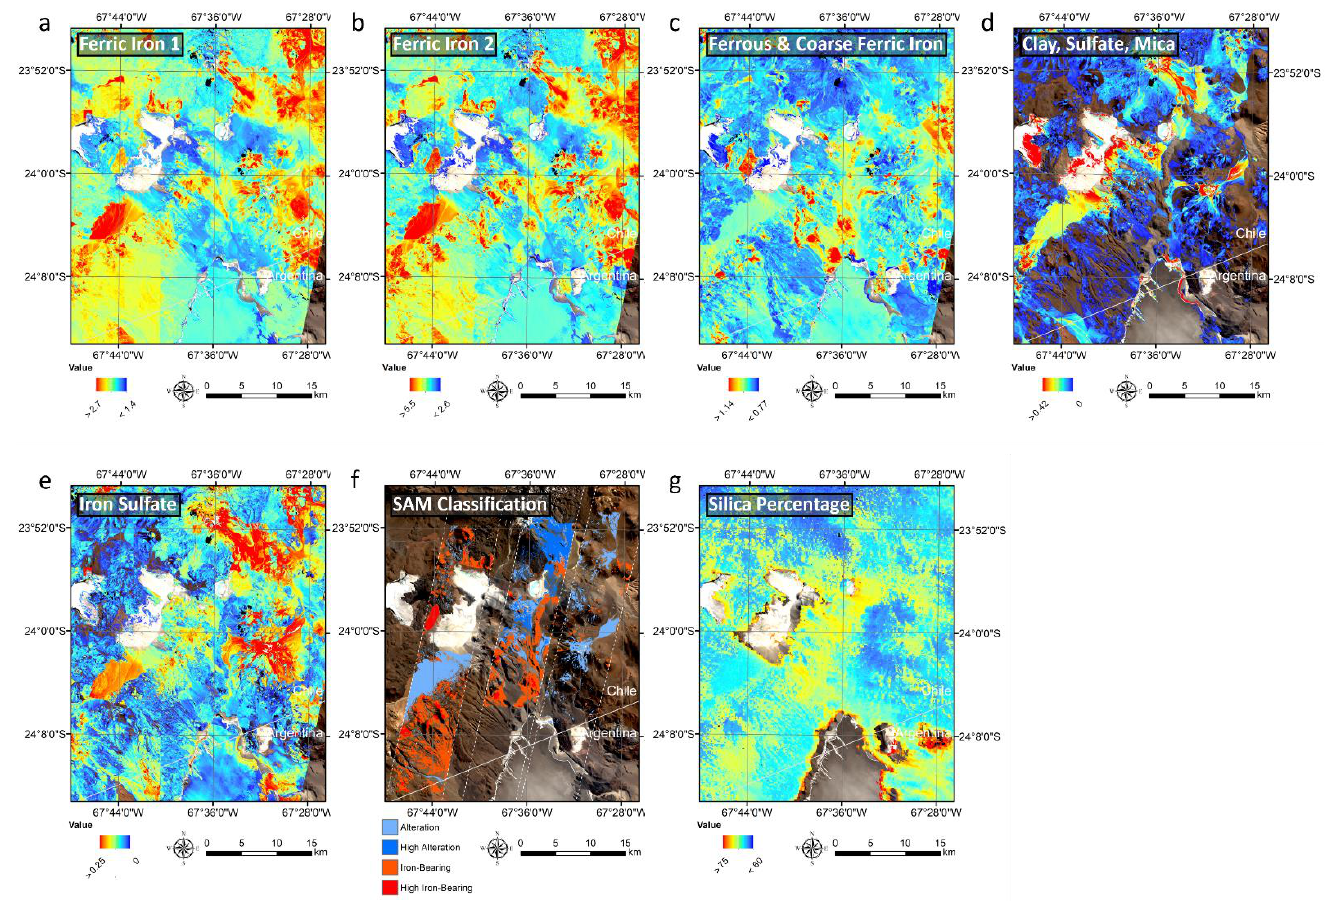
Figure 6. Maps of the region near Lake Tuyajto and Salar de Talar (67°47 ′ 60 ″ S, 23°48 ′ 36 ″ W to 67°26 ′ 24 ″ S, 24°13 ′ 12 ″ W). ( a ) Landsat 8 OLI ferric iron 1 “redness” band ratio index. ( b ) Landsat 8 OLI ferric iron 2 band ratio index. ( c ) Landsat 8 OLI ferrous/coarse-ferric iron band ratio index. ( d ) Landsat 8 OLI clay-sulfate-mica band ratio index. ( e ) Landsat 8 OLI iron-sulfate band ratio index. ( f ) EO-1 Hyperion SAM classification result. “Alteration” and “High Alteration” groups are based on montmorillonite and alunite/kaolinite minerals, respectively. “Iron-Bearing” and “High-Iron- Bearing” groups are based on moderate hematite and high hematite/hornblende spectral signatures, respectively. ( g ) Estimated silica percentage from ASTER imagery.